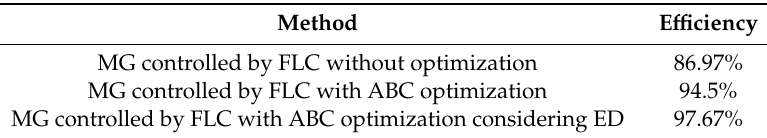
Table 8. System e ffi ciency in three di ff erent methods.